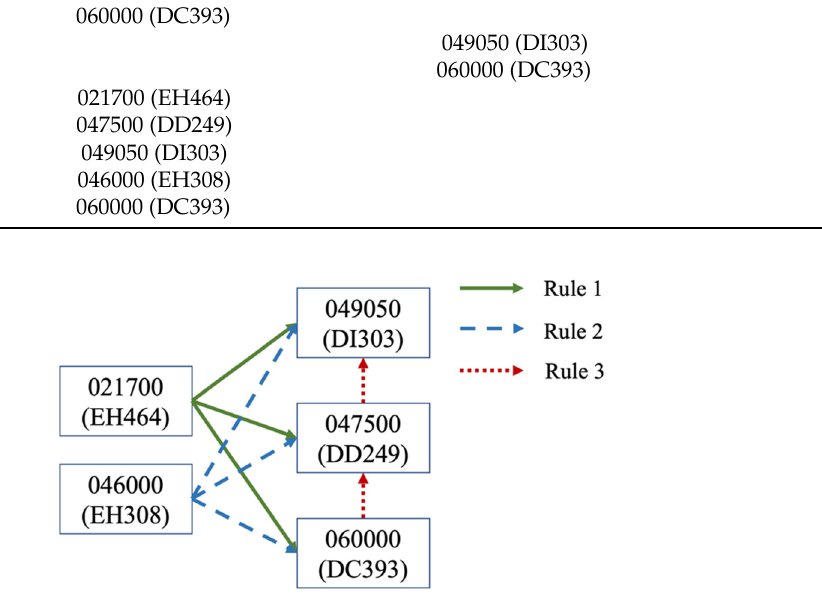
Figure 3. Rules for station–equipment combinations with support rates between 70% and 75% and confidence levels greater than 85%.